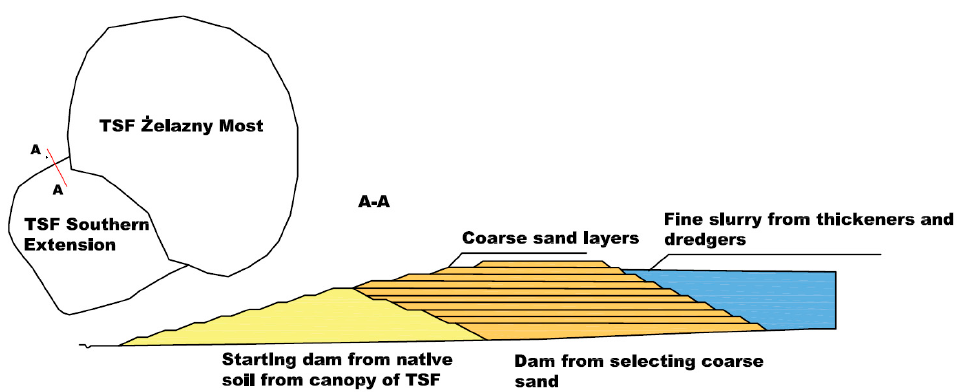
Figure 2. The cross-section of the dam of the South Extension (SE). The distribution of structural material in the body of the dam. material in the body of the